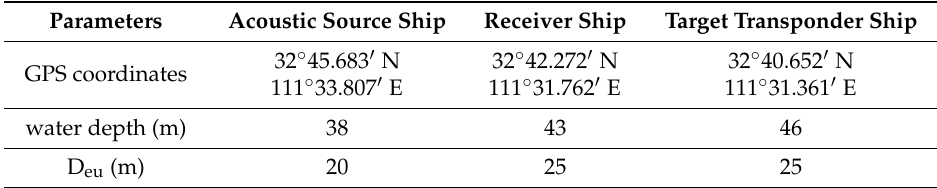
Table 2. Experiments geographical environment parameters.